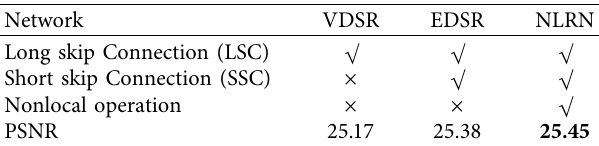
Table 1: Average PSNR (dB) of VDSR, EDSR, and NLRN for × 4 super-resolution reconstruction on test